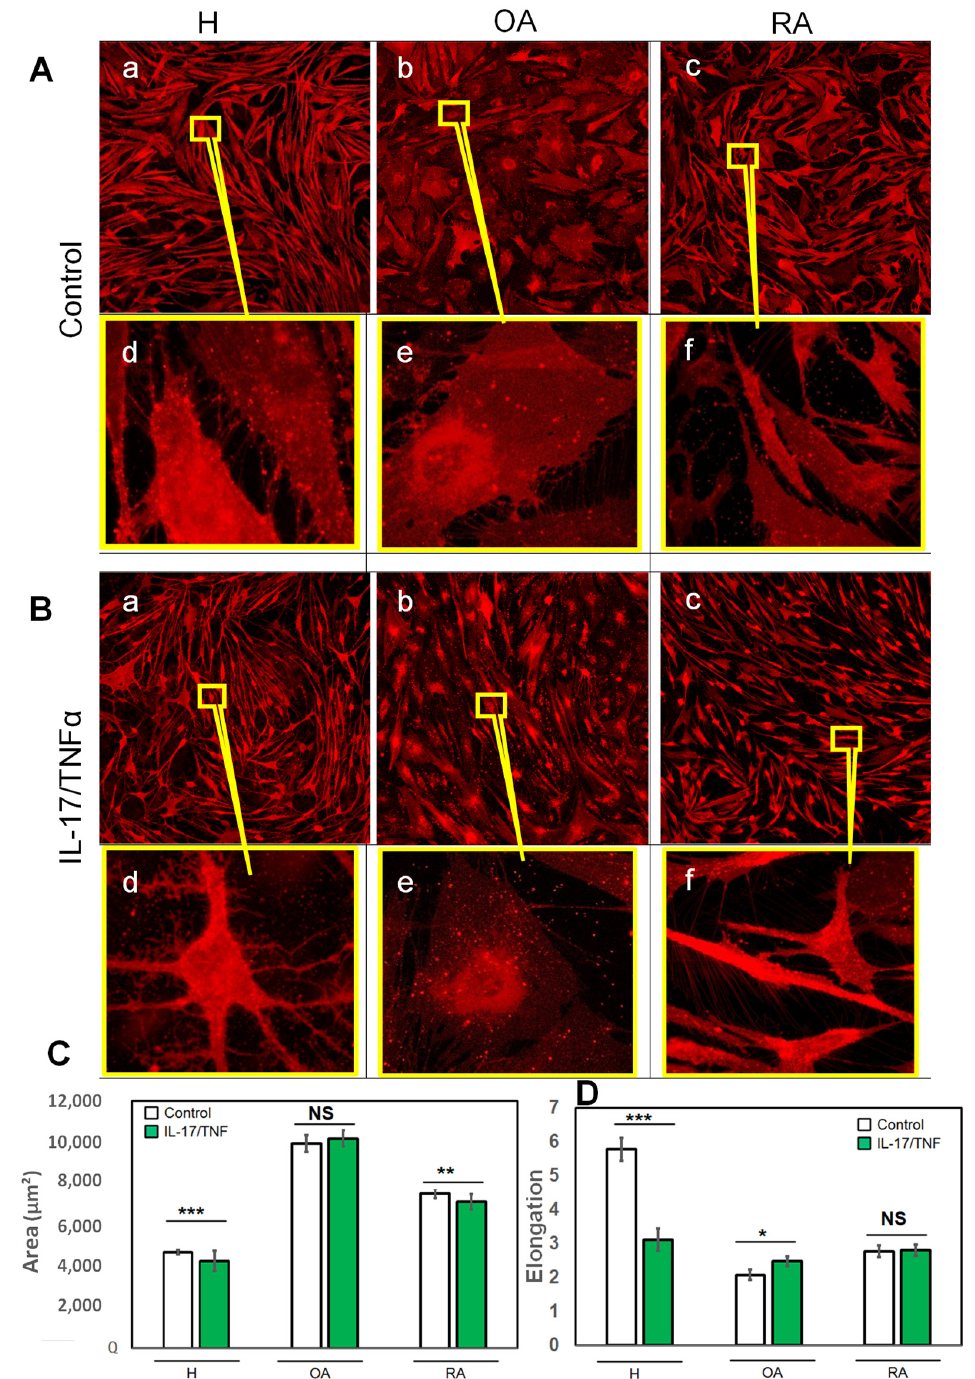
Figure 2. Structural characterization of FLS in the absence ( A ) or presence ( B ) of an inflammatory environment (IL-17: 50 ng/mL, TNF- α : 1 ng/mL). Cells at 20 days of culture after passage P6 were labeled with lipid fluorescent label “DiI” ( λ ex~549 nm) in all cases. Differences in cells morphology in terms of shape, spread and number of pseudopodia were observed by confocal microscopy ( a – f ). Synoviocyte area ( µ m 2 ) ( C ) and elongation ( D ) in the absence or presence of inflammatory environment. Bars represent mean ± SEM. *** p < 0.0001, ** p < 0.001 * p < 0.01 and NS